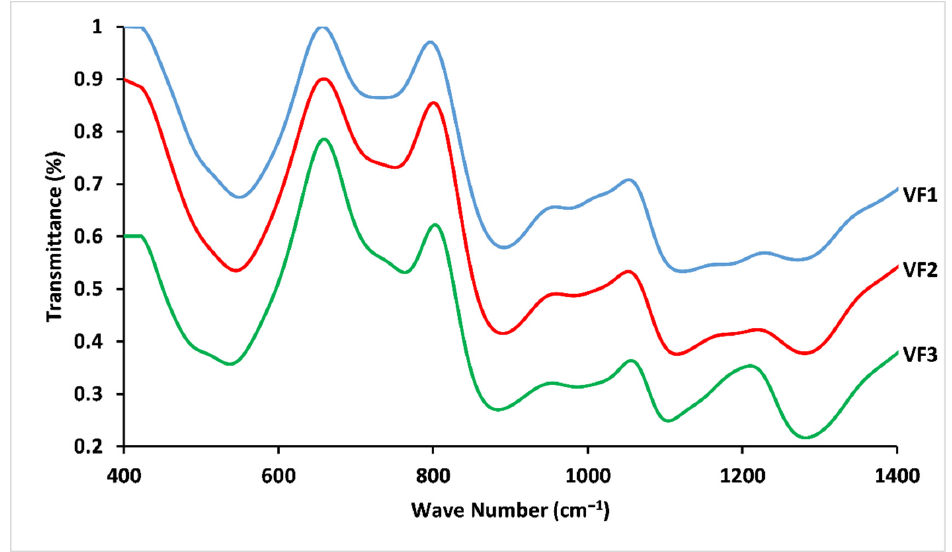
Figure 5. FTIR spectra for concentrations of [K 2 O/(CaO+MgO)] ratio (%mol). VF1: 0.67 %mol, VF2: 1.33 %mol and VF3: 2 %mol.